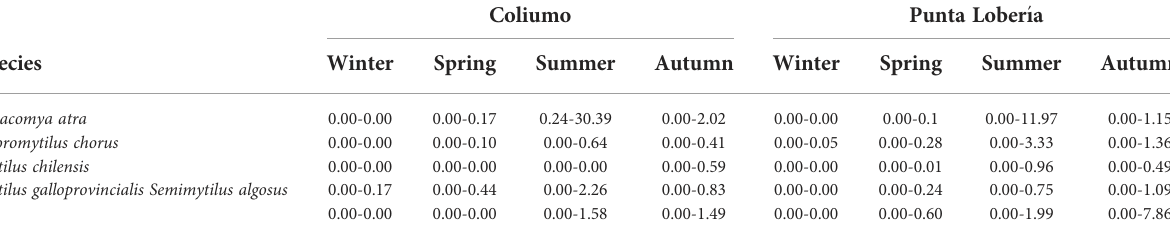
TABLE 1 Density ranges (ind cm-2) of spat species settled in collectors at both sites throughout the four seasons of the study year.